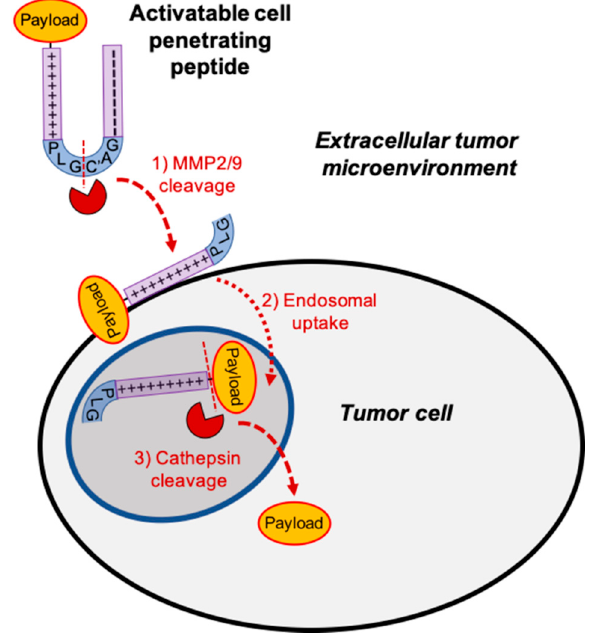
Figure 1. Tumor targeted activatable cell penetrating peptides. Model for activatable cell penetrating peptide tumor localization. Polycationic cell penetrating peptide (+) and autoinhibitory polyanionic peptide ( − ) are connected by a metalloproteinase (MMP) 2/9 sensitive peptide linker (PLGC(Me)AG).